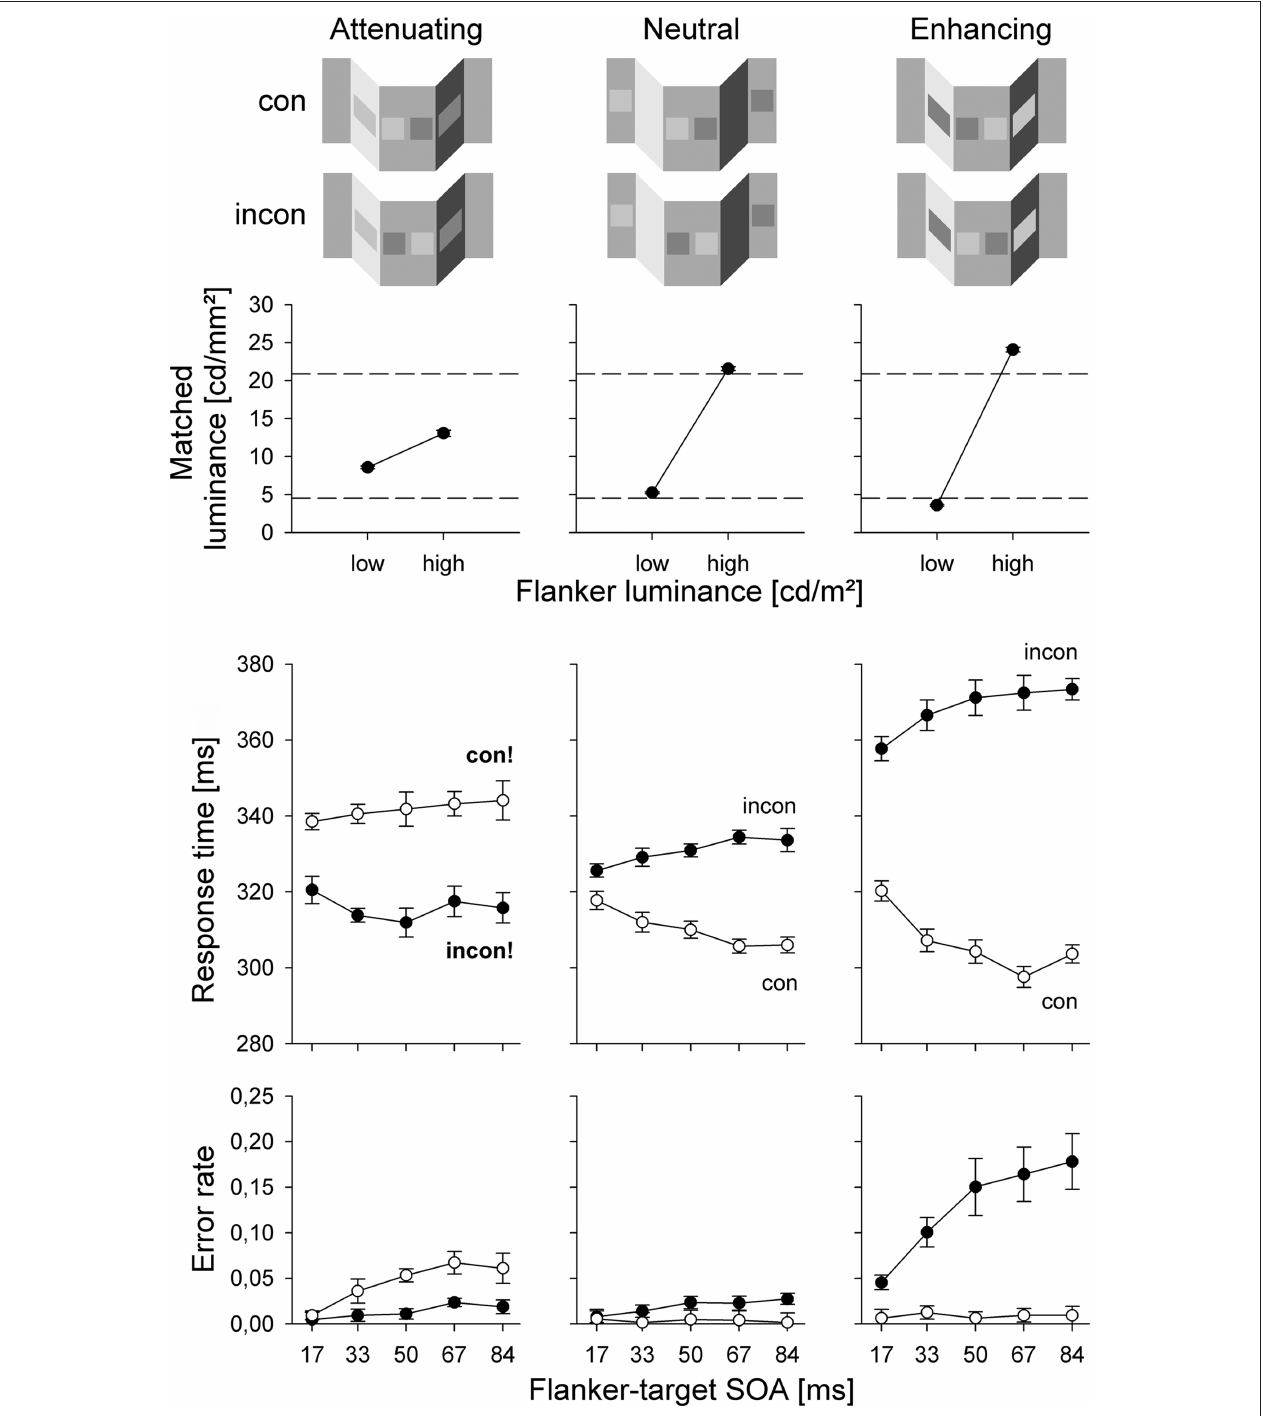
Figure 6 | results from Schmidt et al. (2010). Upper panel: results of the matching task where participants matched the brightness of the targets to the brightness of the adjacent flankers. Stippled lines denote veridical values. Lower panels: priming effects. Note the reversal in priming for response times and error rates under the attenuation